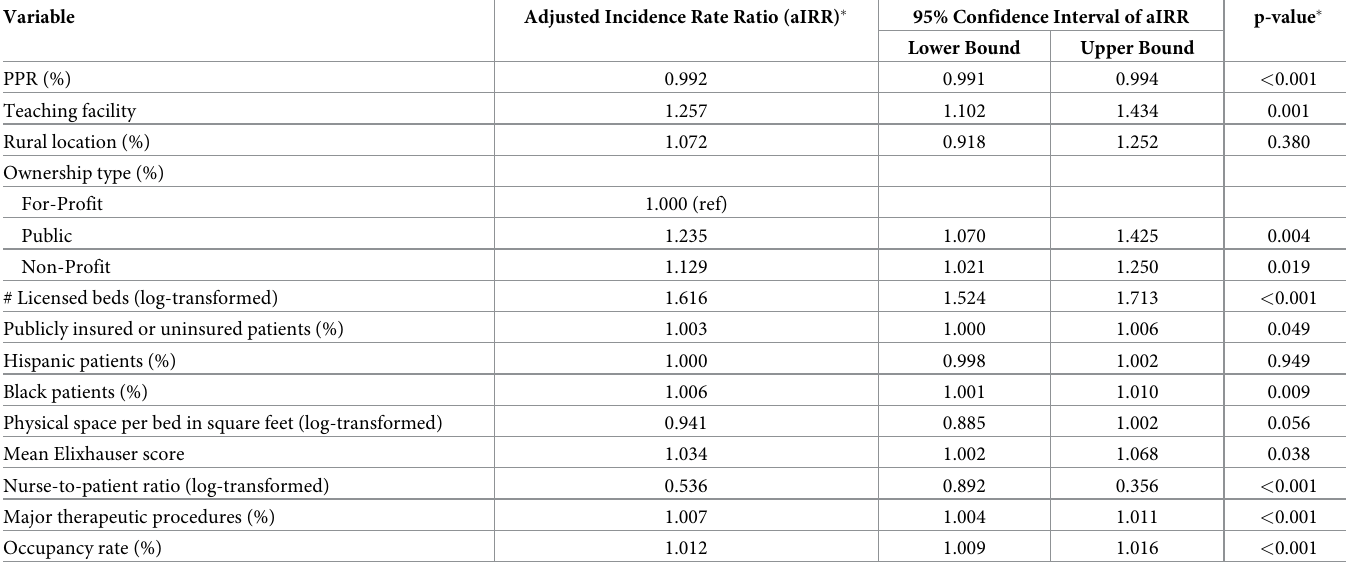
Table 2. Adjusted associations between the characteristics of 340 US hospitals and rates of methicillin-resistant Staphylococcus aureus (HA-MRSA) infections for discharges between September 2015 and August 2016.